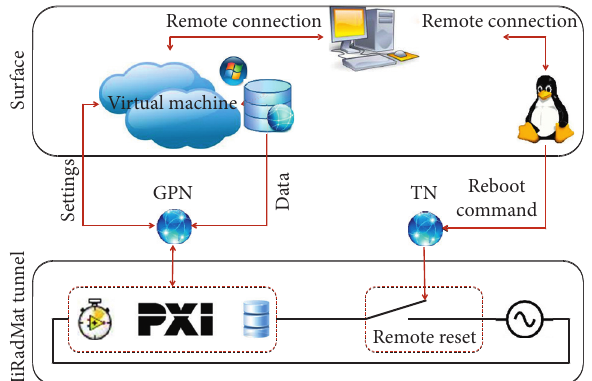
Figure 17: SHC-DAQ